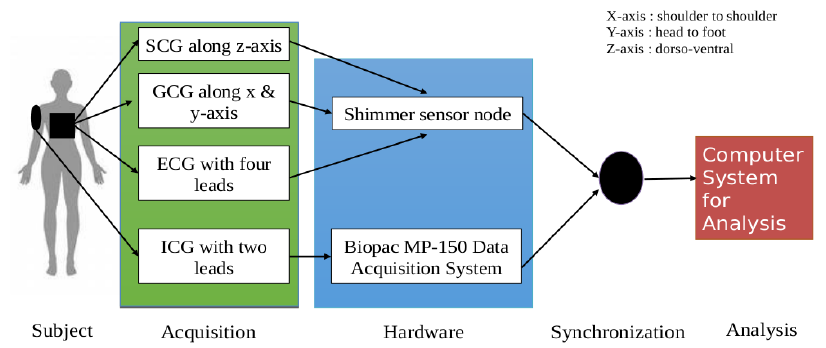
Figure 3. SCG contact-based hardware setup containing accelerometer and gyroscope.